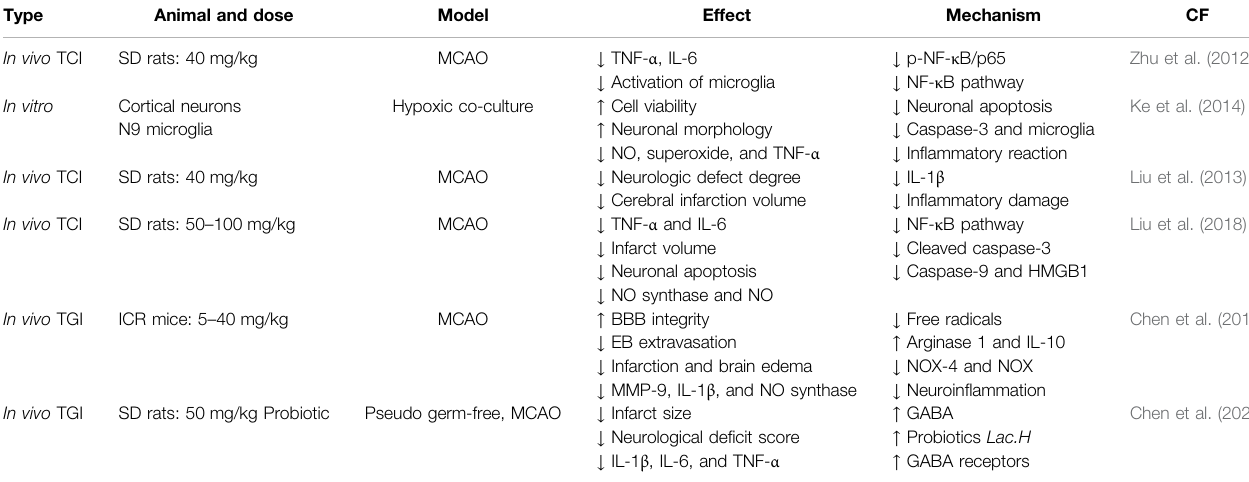
TABLE 2 | Neuroprotective effects of GRb1 on cerebral ischemia injury are mediated by suppressing neuroin fl ammation and microglia-mediated in fl ammatory reactions, based on current reports and results.